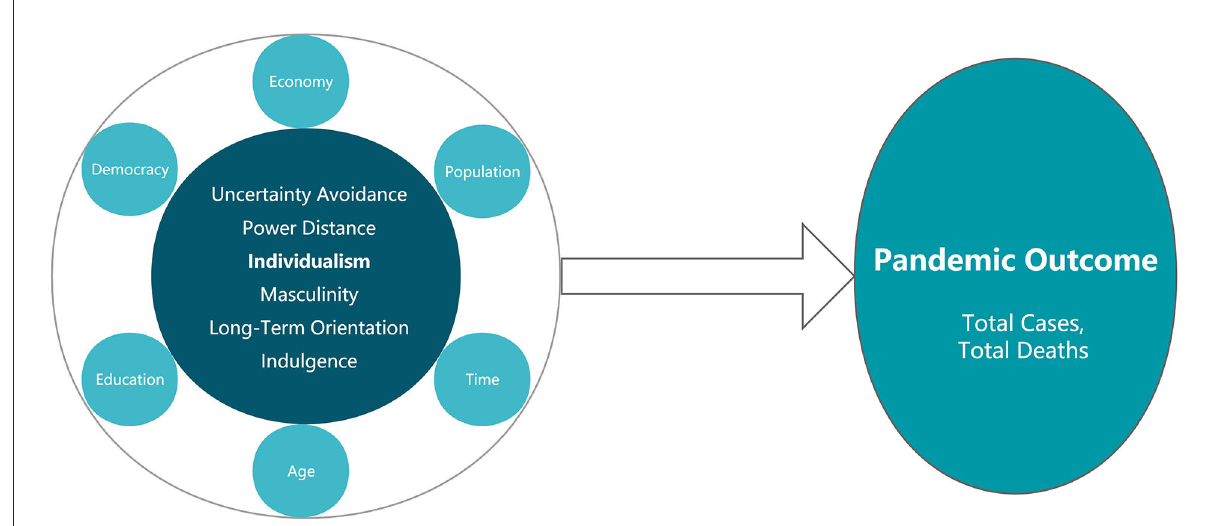
FIGURE1 Mediating effect of policy response. Source: Drawn by the